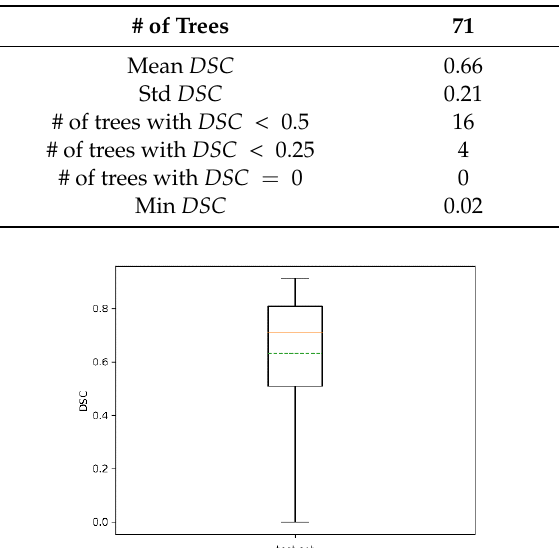
Figure 12. Boxplot of DSC for the test set. The dotted green line represents the mean.